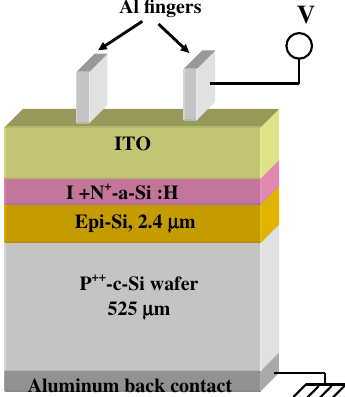
Fig. 1. Schematic diagram of the epitaxial silicon solar cell.